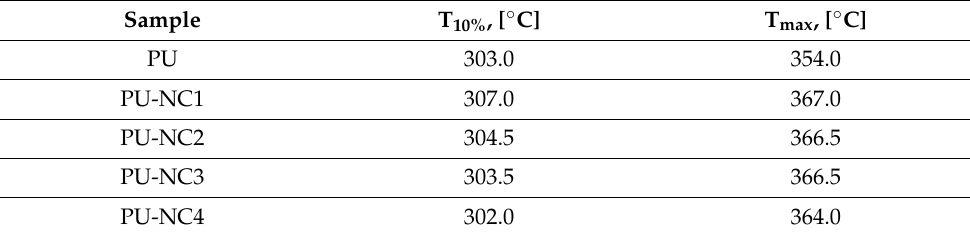
T 10% = decomposition onset temperature (measured at 10% weight loss); T max = the maximum de- composition temperature, corresponding to the maximum of DTG peak (the first derivative of the thermogravimetric curve). Table 3. The decomposition process of the polyurea-polyurethane-MWCNTs nanocomposites. Weight Loss Sample